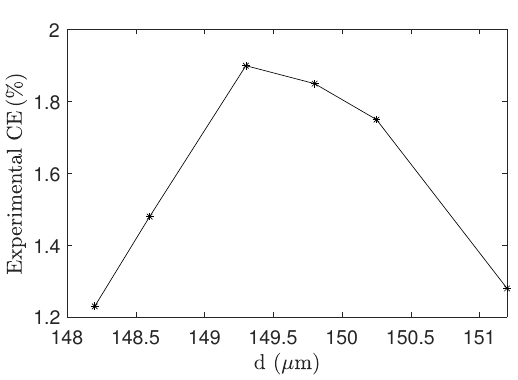
Figure 5. Experimental CE for an equivalent b 1456 mode as a function of the transverse distance d . The pendant droplet has a radius of R = 156 . 5 μ m, and it is made of silicone oil with = 1 . 3989. The laser is works at 640 n r